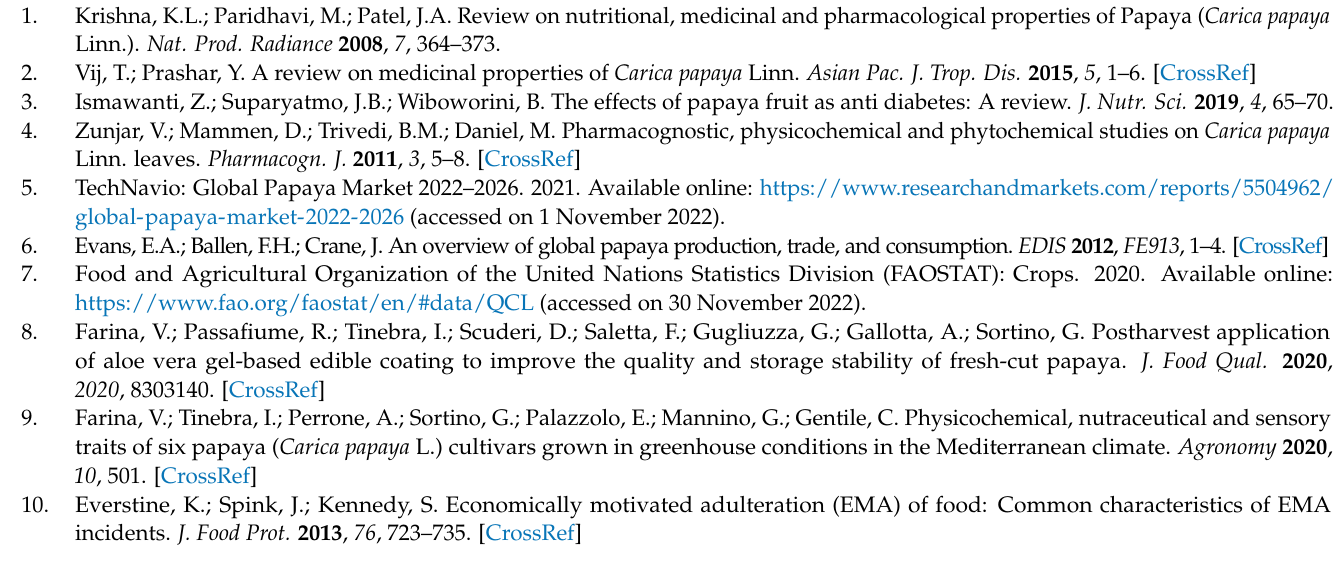
papaya samples used in this study to voucher and reference material sequences collected in house and from public databases, Figure S3: (A) Standard curve created using serial dilutions of DNA extracted from USA-sourced Carica papaya . (B) Linearity and efficiency calculations from standard curve., Table S1: Repeatability evaluation using DNA from fresh C. papaya samples., Table S2: Reproducibility evaluation using DNA from processed C. papaya